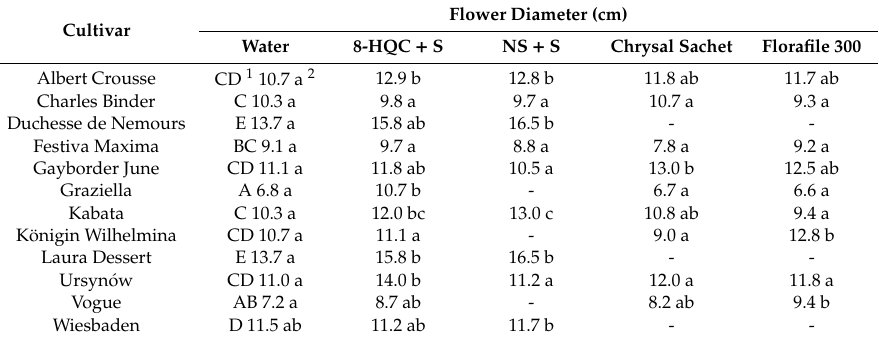
Table 2. The e ff ect of preservatives on the flower diameter of cut peony flowers. Cultivar